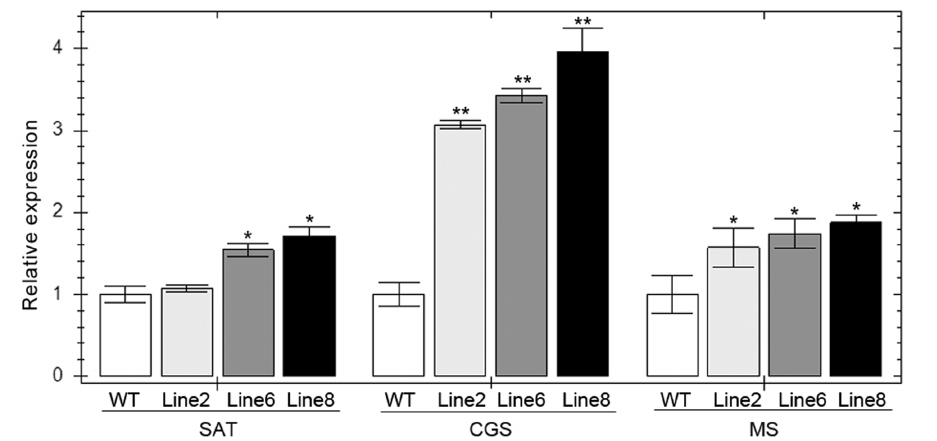
Figure 4. Relative expression levels of SAT, CGS and MS in wild-type and transgenic plants. Lane WT: wild-type line; Lane 2,6,8: Line 2,6,8 transgenic alfalfa lines. SAT: serine acetyltransferase; CGS: cystathionine c -synthase; MS: methionine synthase. * represents statistically significant differences (P , 0.05). ** represents statistically significant differences (P , 0.01).